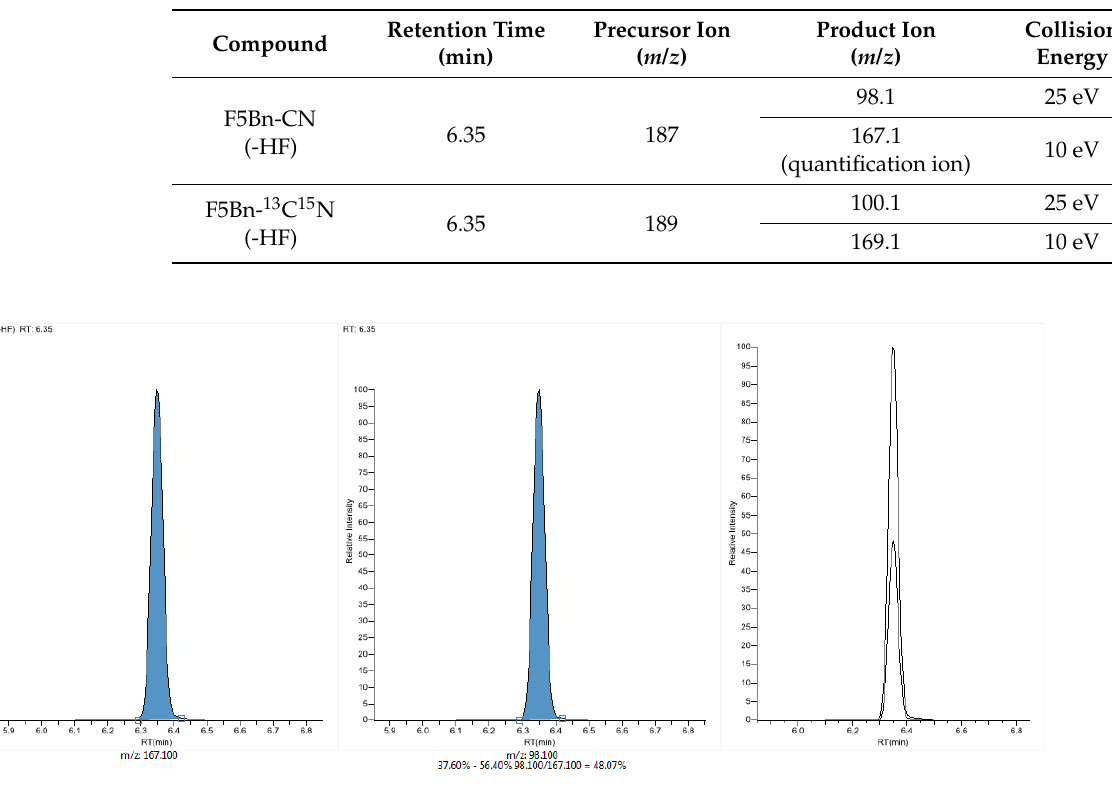
Figure 3. Mass chromatograms of PFB-CN obtained from cyanide spiked blood samples: quan peak 187 → 167.1, confirmation peak 187 → 98.1, and ion overlay chromatogram.